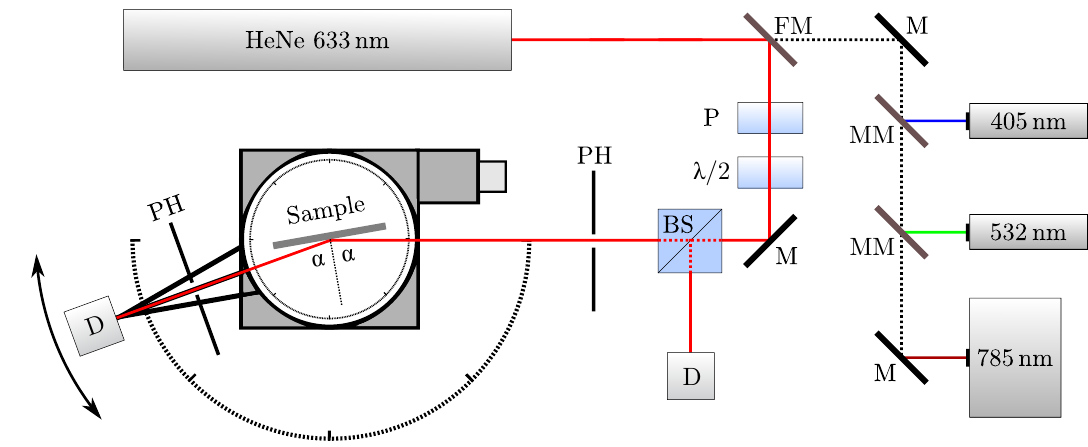
Figure 2. Experimental setup for investigating the samples with adjustable wavelength, angle of incidence, angle of detection and polarization state (P: polarizer; λ /2: waveplate; PH: pinholes; BS: beam splitter; D: Si-photodiode; FM: flip-mirror; MM: magnetic mirrors; M: